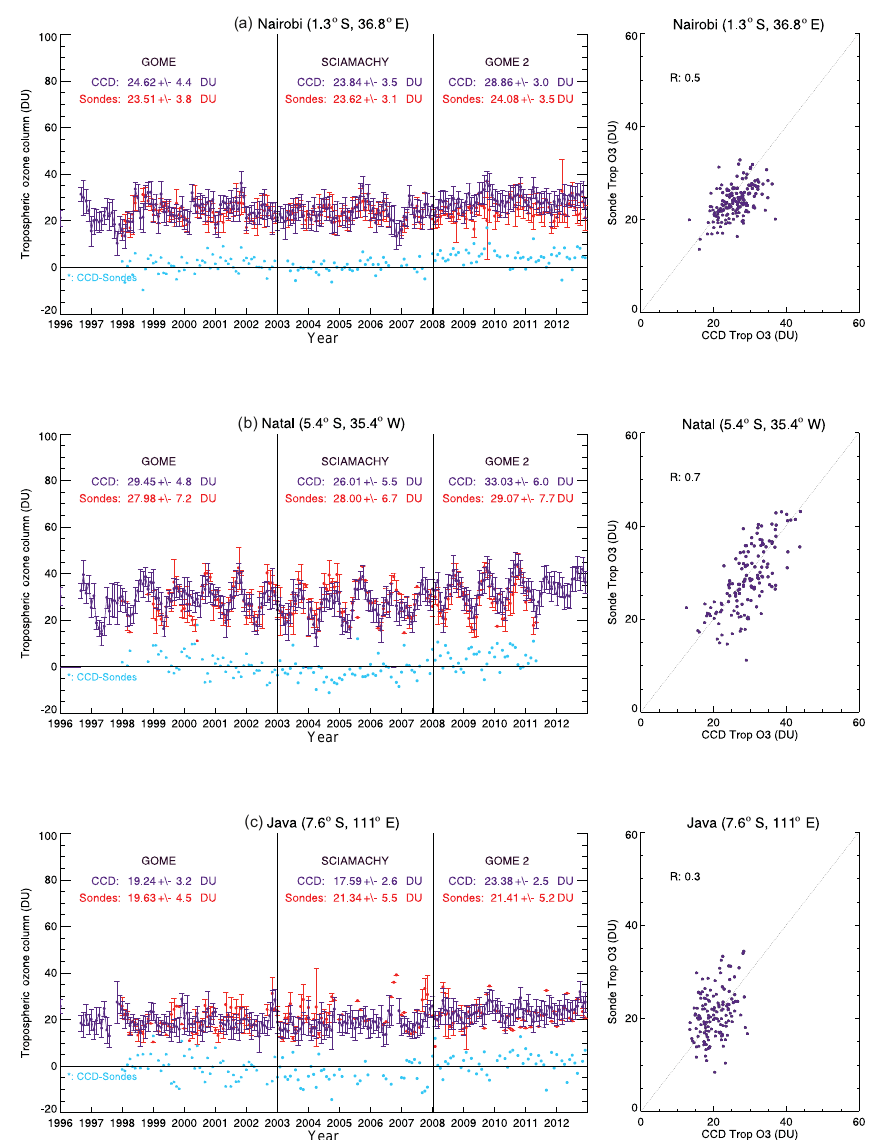
Figure 13. Time series of monthly-mean CCD tropospheric ozone columns and collocated monthly-mean SHADOZ ozonesonde TTCO in Nairobi, Natal, and Java (from top to bottom). The red lines give the integrated ozone column from sonde ozone up to the fixed level of 200hPa (roughly 12km). The blue lines are: (i) GOME-1 CCD ozone columns (1996–2002), (ii) SCIAMACHY CCD ozone columns (2003–2007), and (iii) GOME-2 CCD ozone columns (2008–2012). Error bars indicate the standard deviation of the monthly mean. No error bars are shown for months with only one ozonesonde launch available. The difference between CCD and ozonesondes is plotted with light blue